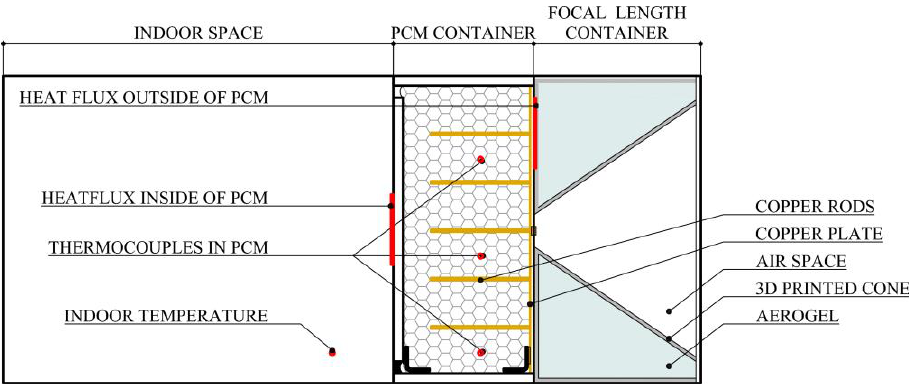
Fig. 5. Monitoring equipment